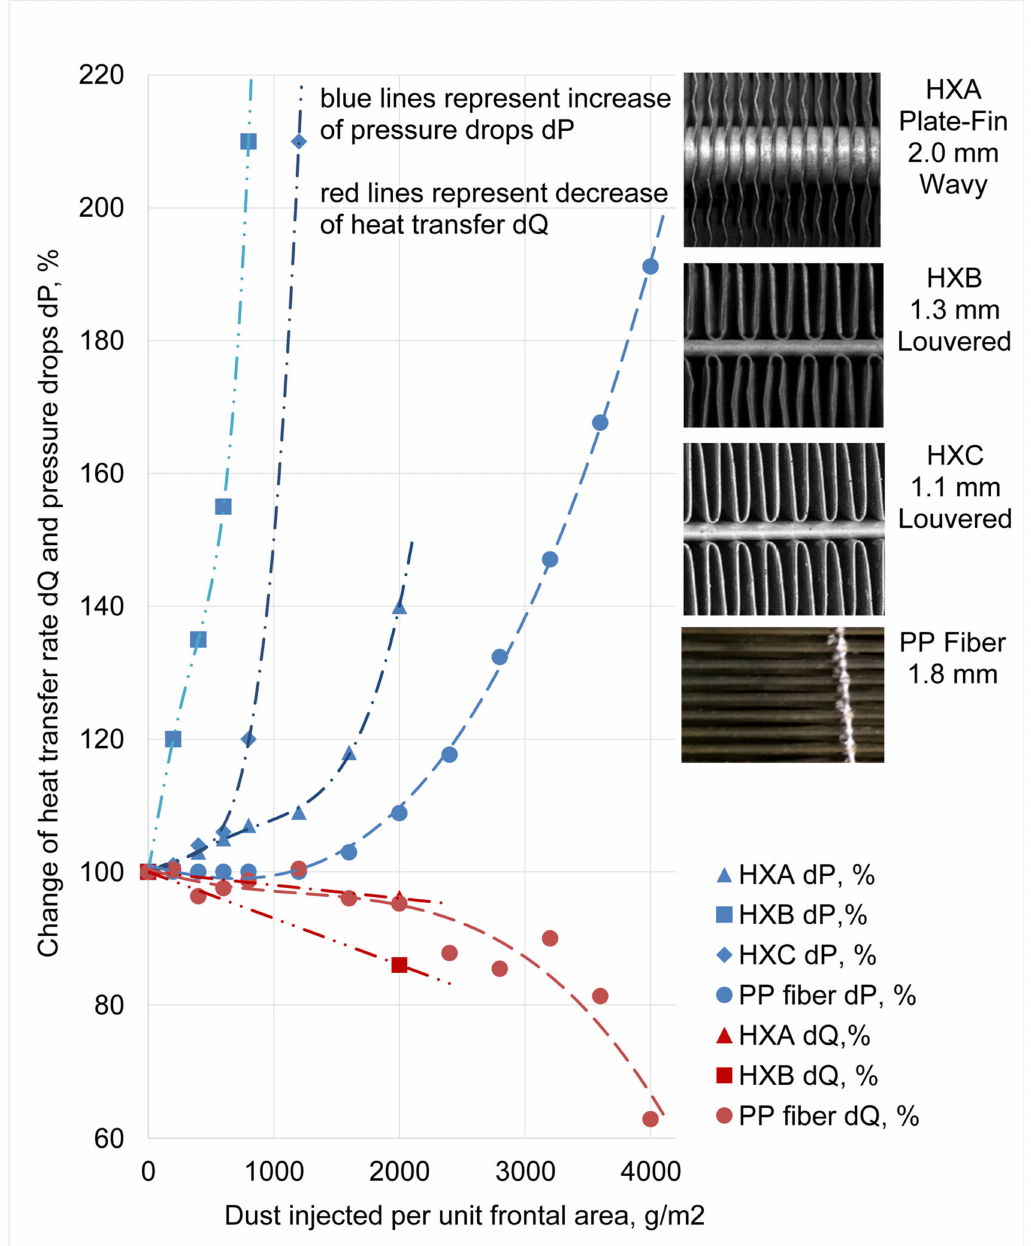
Figure 11. Comparison of fouling characteristics of finned tube heat exchangers HXA. HXB and HXC and polymeric hollow fiber heat exchanger. Data for HXA. HXB and HXC are adopted from Bell and Groll